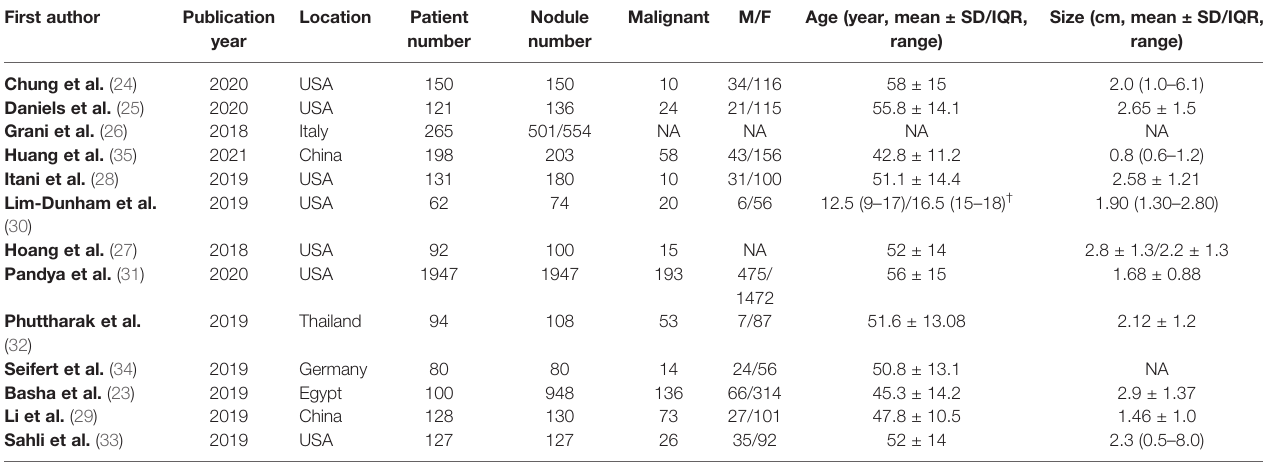
TABLE 1 | Demographic characteristics of included